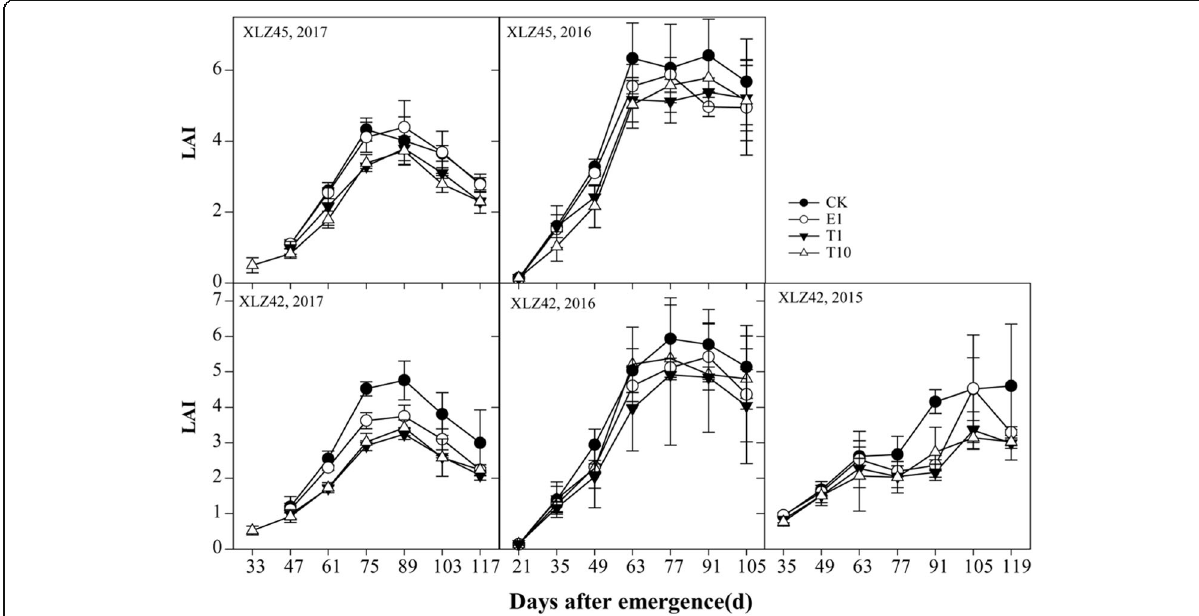
Fig. 10 Leaf area index (LAI) variation of two cotton varieties (XLZ42 and XLZ45) in various treatment groups: 1 and 10 days before the first irrigation (T1, T10, respectively) and 1 day before the second irrigation (E1) after seedling emergence, during 2015 – 2017. The control group (CK) had film mulching throughout the growth stages. Bars are means ± standard deviation (n =